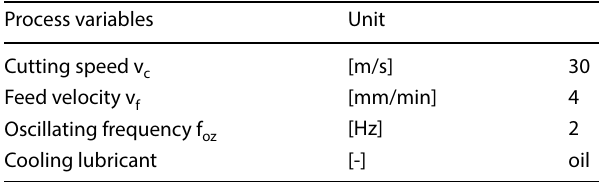
Table 3 Parameter settings of the grinding experiments